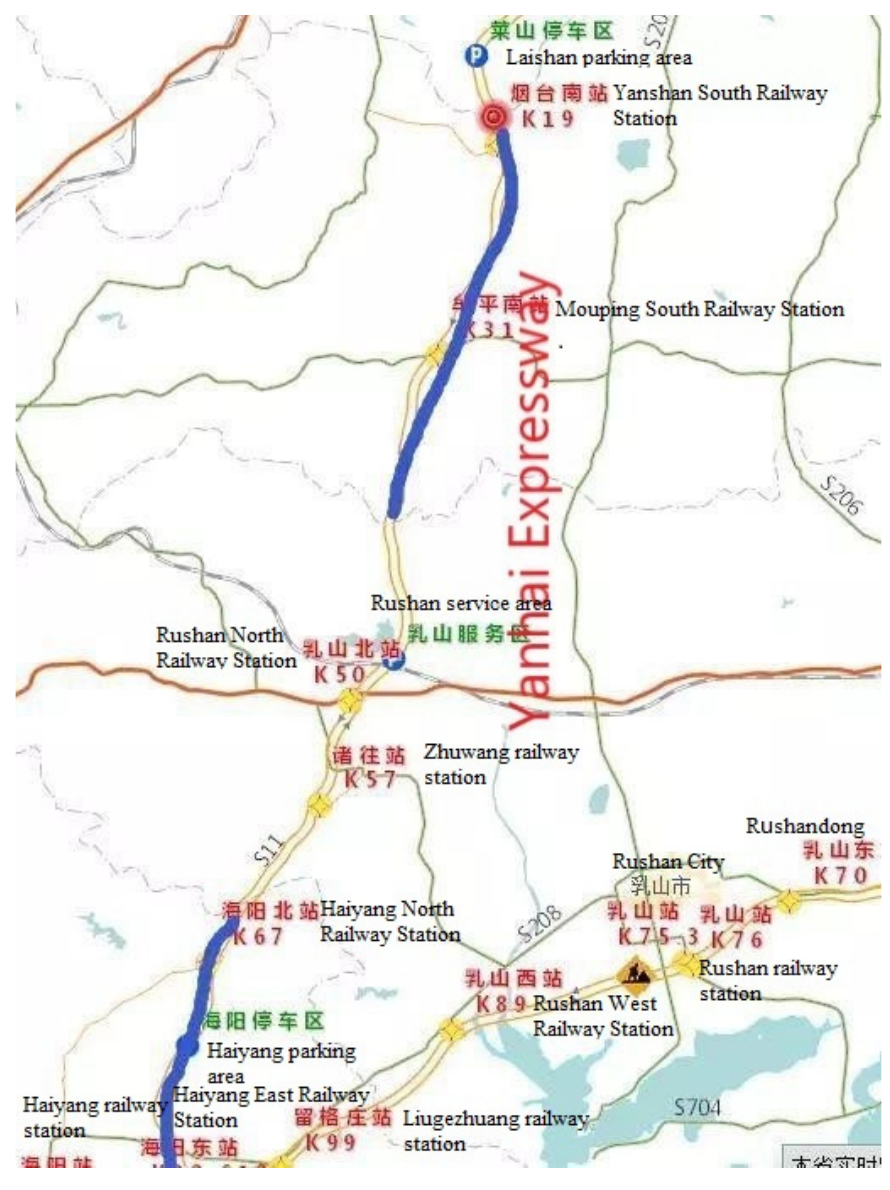
Figure 1. Vehicles’ driving